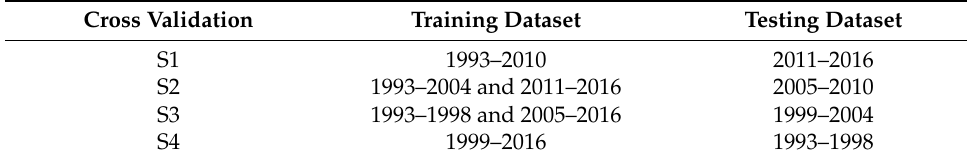
Table 4. The different cross-validation stages used in this